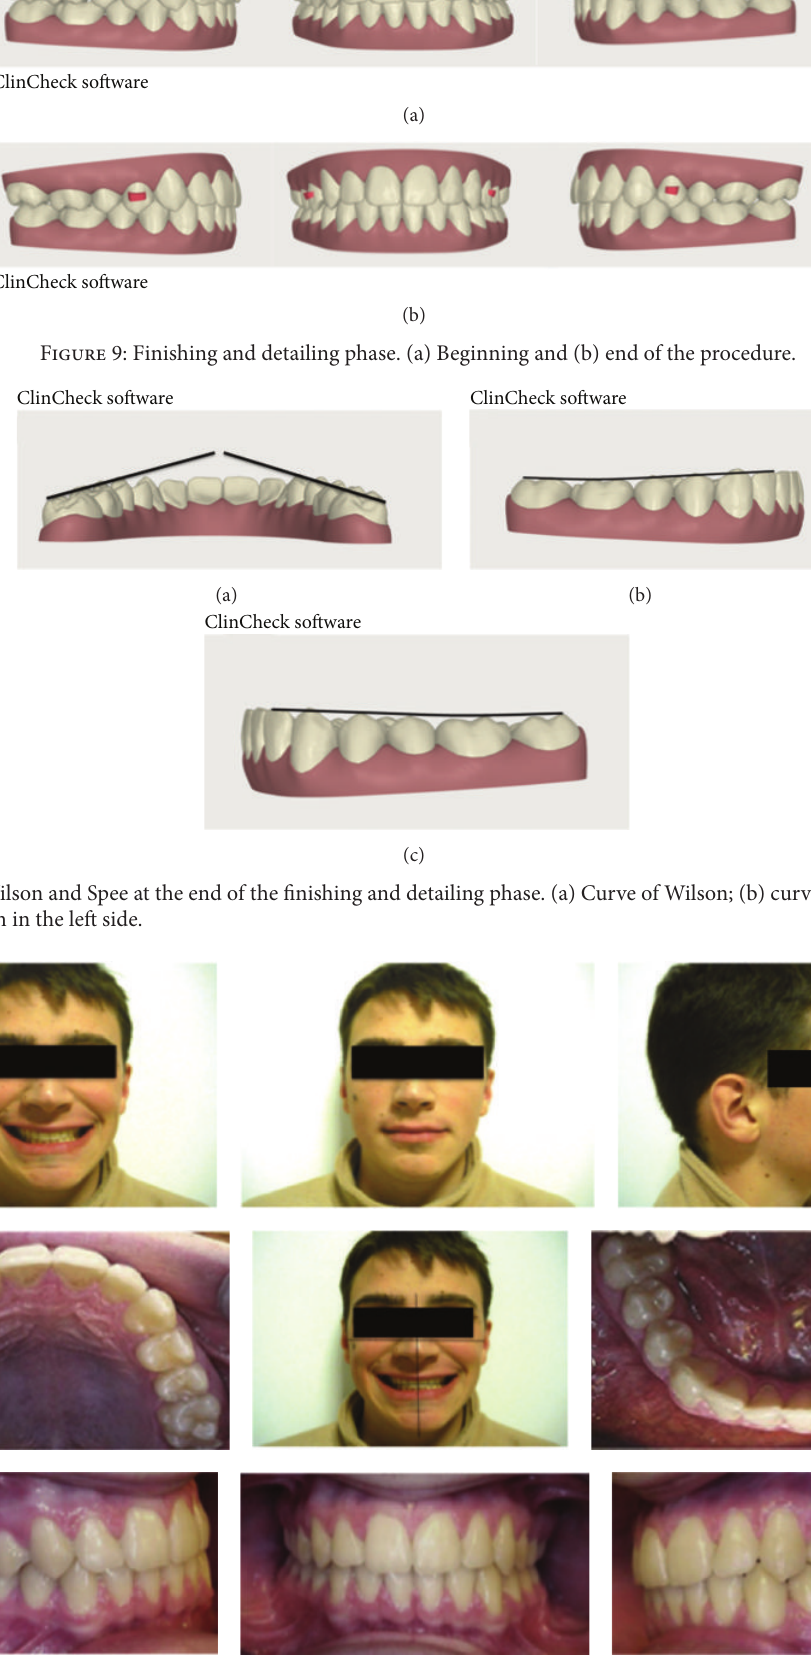
Figure 11: Clinical pictures of the patient at the end of the surgical and orthodontic